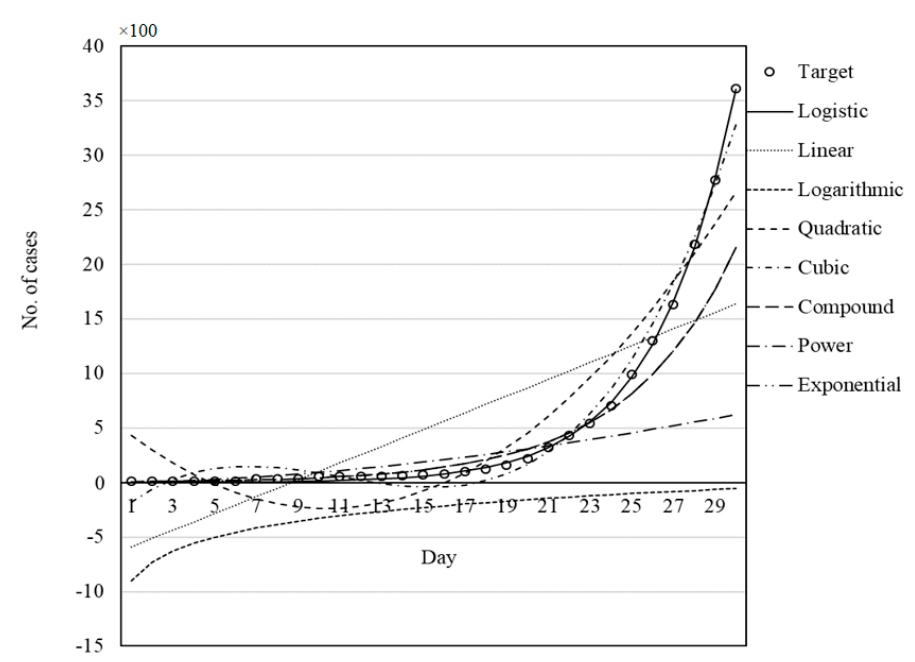
Figure 11. Set of models for USA fitted by GWO.